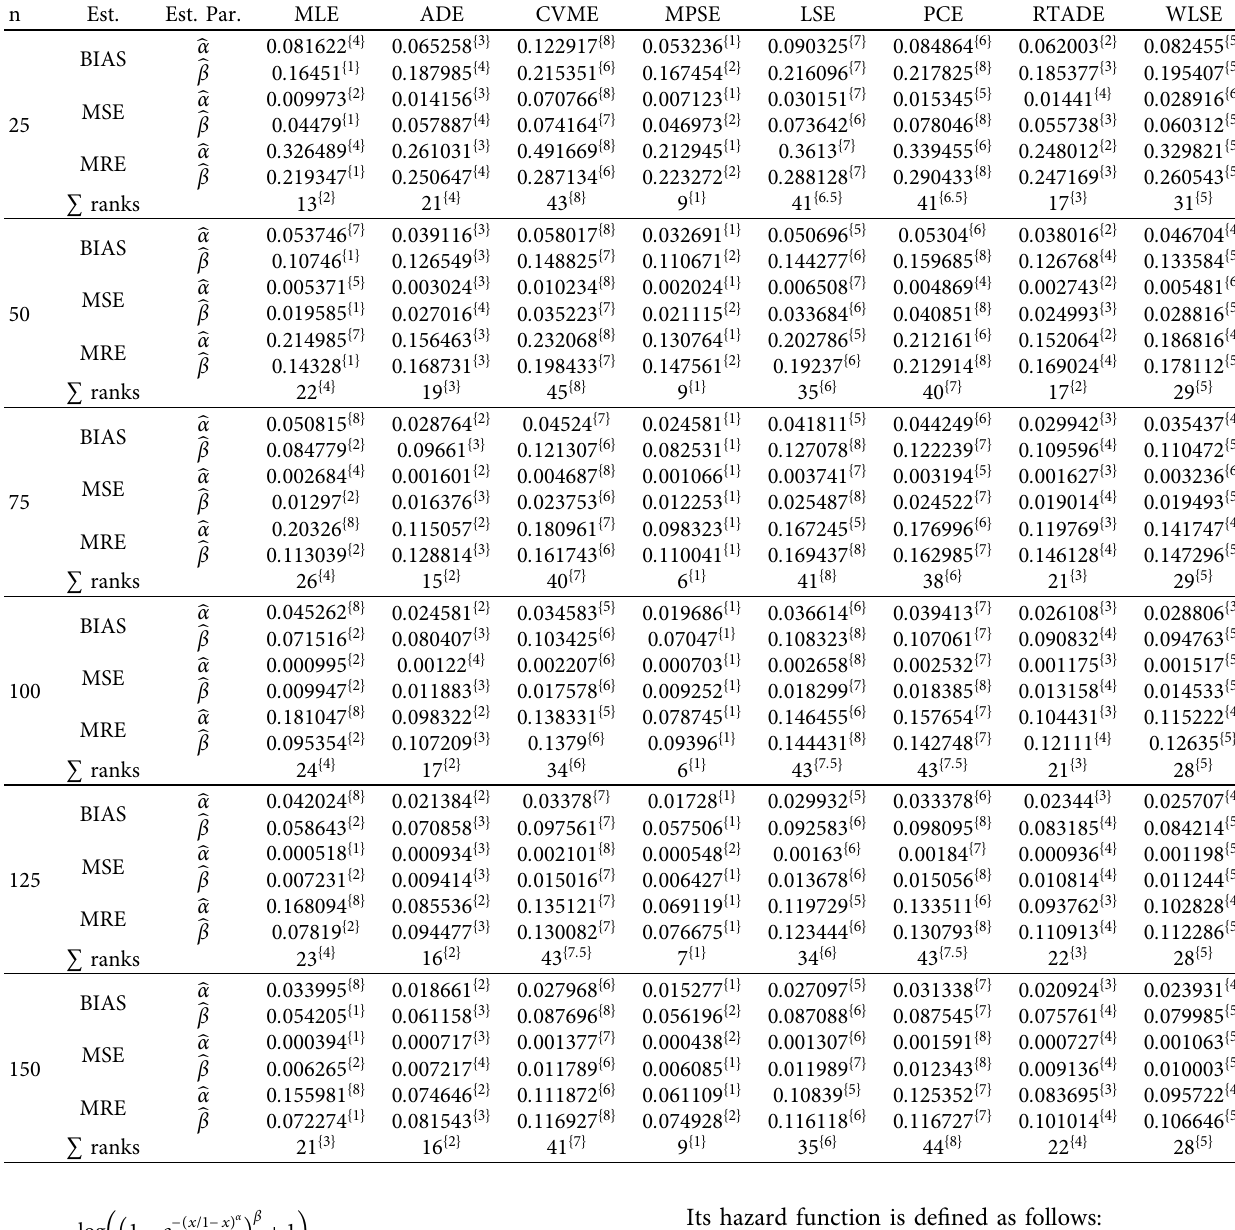
Table 1: Simulation values of BIAS, MSE, and MRE for α � 0 . 25 , β � 0 .